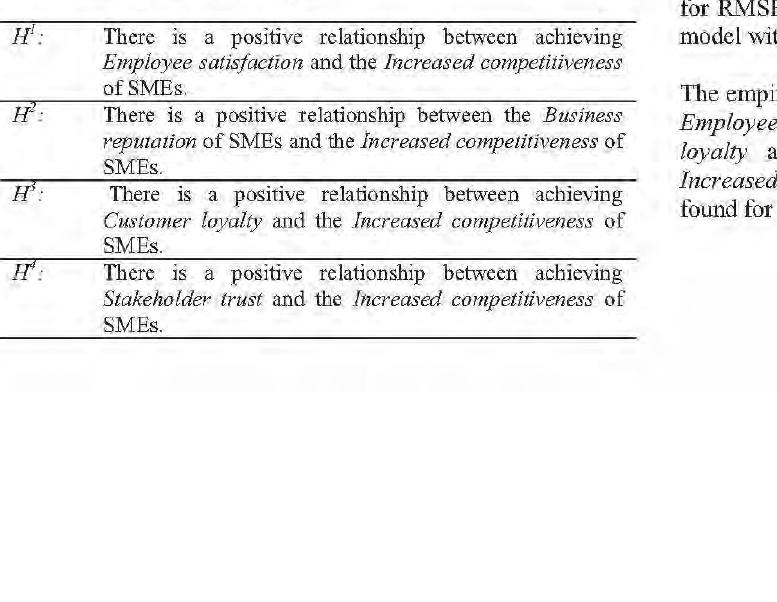
Table 4: Reformulated